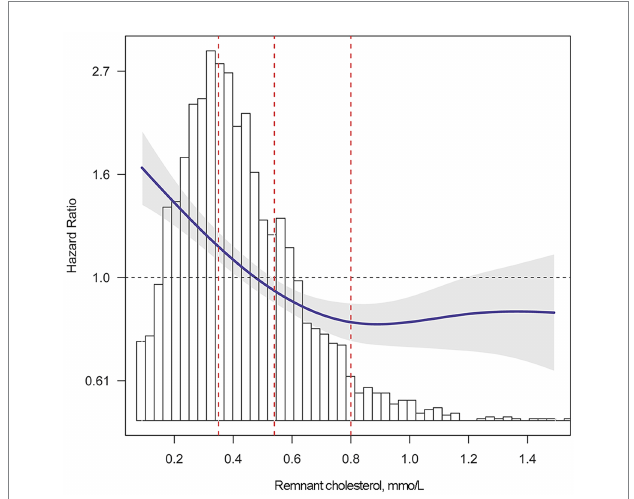
FIGURE 3 Adjusted risk of all-cause mortality by remnant cholesterol level. Smooth curve fitting was performed to explore the association between remnant cholesterol and the risk of all-cause mortality. Multivariate Cox regression was adjusted for sex, age, body mass index, hypertension, diabetes mellitus, coronary heart disease, heart rate, systolic pressure, diastolic pressure, hemoglobin, albumin, alanine aminotransferase, aspartate transaminase, total bilirubin, serum uric, estimated glomerular filtration rate, high sensitivity C reactive protein, log(N-terminal pro-brain natriuretic peptide), left ventricular ejection fraction, New York Heart Association Functional Class and pharmacotherapy. The solid blue line indicates the adjusted risk of all-cause mortality. The gray shading indicates the 95% confidence interval. The red dotted lines indicate the first, second and third quartile of remnant cholesterol, left to